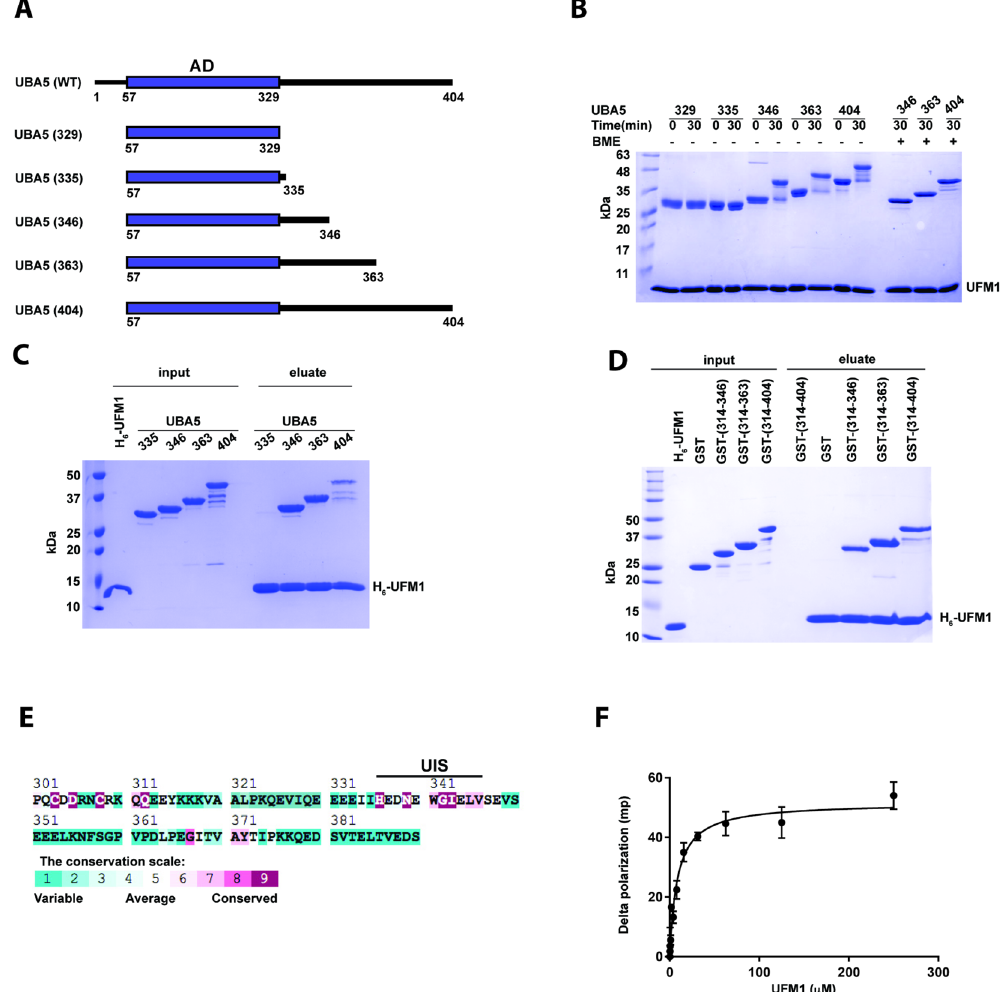
Figure 1. UBA5 possesses a UFM1-binding sequence that is essential for UFM1 activation. ( A ) UBA5 constructs used in this study; AD is adenylation domain. ( B ) Charging assay of UBA5 constructs (10 μ M) with UFM1 (50 μ M). All constructs start at amino acid 57 and end as indicated by the number in the figure. ( C ) Pull down assay showing binding of UBA5 constructs (numbered as in B) to immobilized H 6 -UFM1. ( D ) Pull down assay showing binding of GST-UBA5 constructs to immobilized H 6 -UFM1. Experiment was performed as in C. ( E ) ConSeq evolutionary conservation analysis 42 of UBA5. UBA5 residues located C-terminal to the adenylation domain are colored based on their conservation score. ( F ) Fluorescence polarization experiment showing binding of UFM1 to fluorescein-labeled UIS peptide K D = 8.5 μ M ± 2.3. Error bars represent the SEM of each